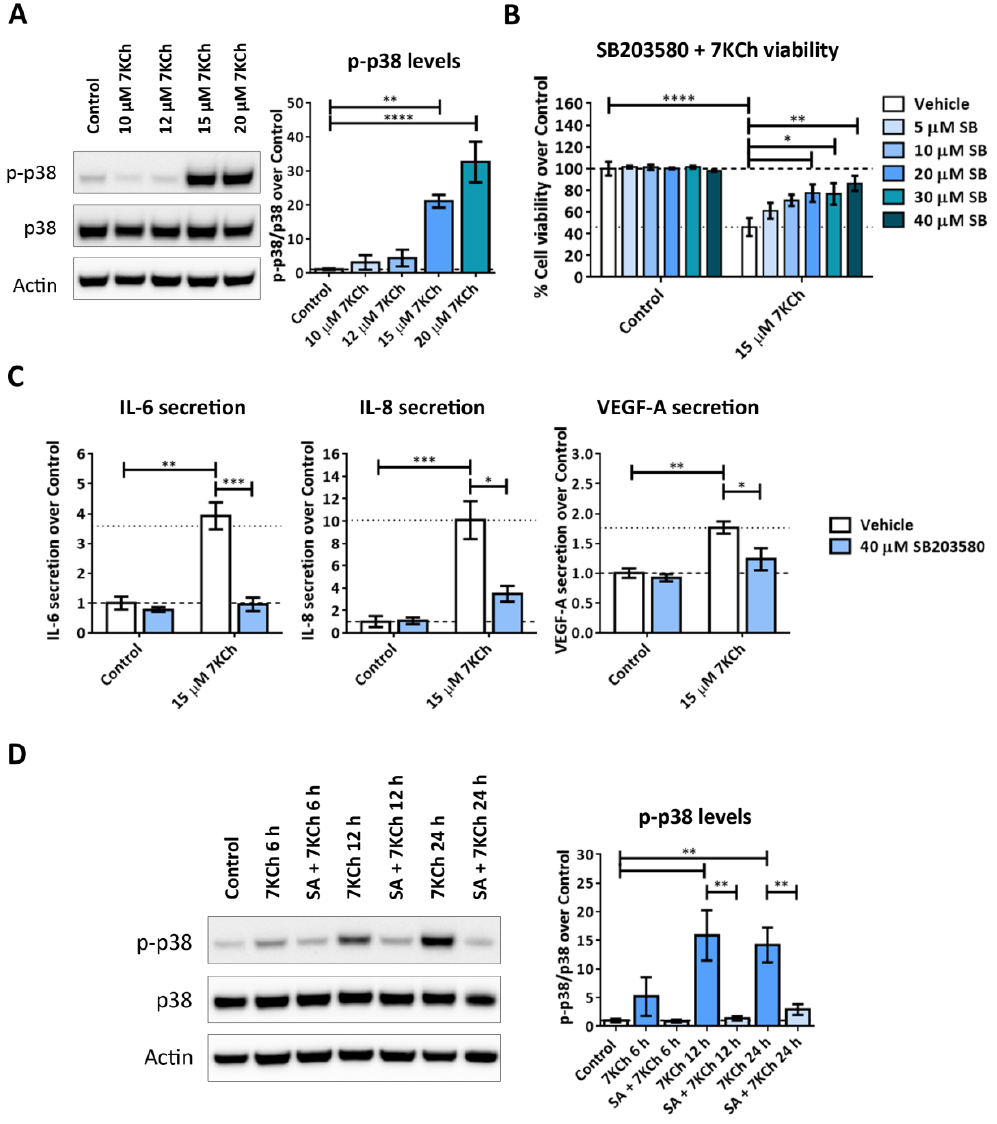
Figure 9. Activation of p38 in response to 7KCh in mRPE cells. ( A ) Western blot estimation of phosphorylated p38 (p-p38) levels in mRPE cells exposed to increasing concentrations of 7KCh for 24 h. ( B ) Cell viability determined by MTS assay in mRPE cells treated with 15 μM 7KCh and increasing concentrations of SB203580 (SB) for 24 h. ( C ) Secreted levels of IL-6, IL-8 and VEGF-A in mRPE cells exposed to 15 μM 7KCh and 40 μM SB203580 for 48 h and measured with ELISA. ( D ) Western blot estimation of p-p38 levels in mRPE cells exposed to 20 μM 7KCh and 10 μM SA for 6 h, 12 h and 24 h. In Western blot assays, p38 levels, previously normalized with respect to Actin, were used to normalize p-p38 quantification. In MTS assay and ELISA, the p38 inhibitor SB203580 was added with a pretreatment of 2 h with respect to 7KCh. The vehicle group in the graphs represents the control (control-vehicle) and the 7KCh (7KCh-vehicle) treatment. Data are represented as mean ± SEM of at least three different experiments. The dashed and dotted lines are a guidance mark of control and 7KCh value, respectively. ANOVA test was used for statistical analysis followed by Tukey (in A , B , D ) or Sidak (in C ) post hoc test.* p < 0.05; ** p < 0.01; *** p < 0.001; **** p < 0.0001. 3. Discussion In this work, we have shown that exposure to 7KCh in RPE cells transcriptionally modulates the expression of several genes associated with different cell processes. Like- wise, co-treatment with SA significantly reverses the alteration exerted by 7KCh over sev- eral key genes, as well as attenuates the activation of the signaling pathways associated